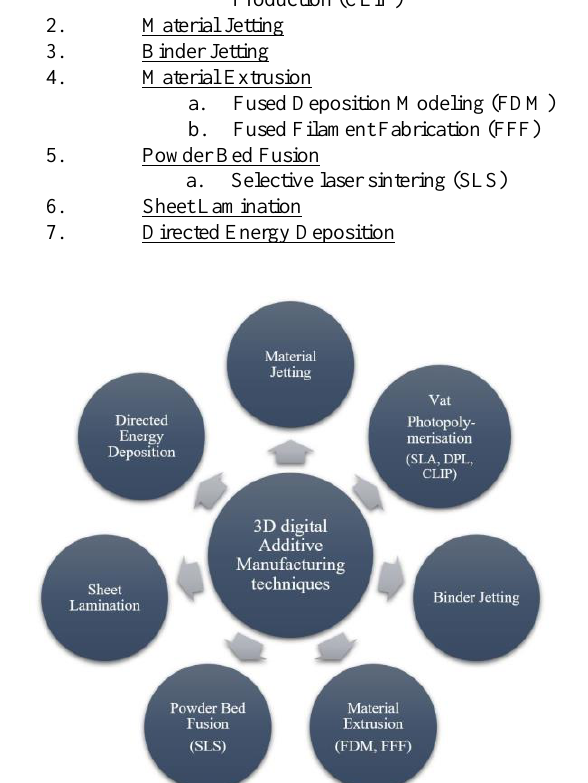
Figure 1. Different types of 3D